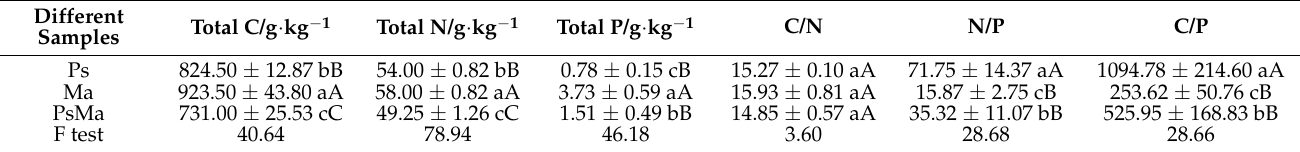
Table 1. Chemical properties of leaves with different proportions of leaf litter.